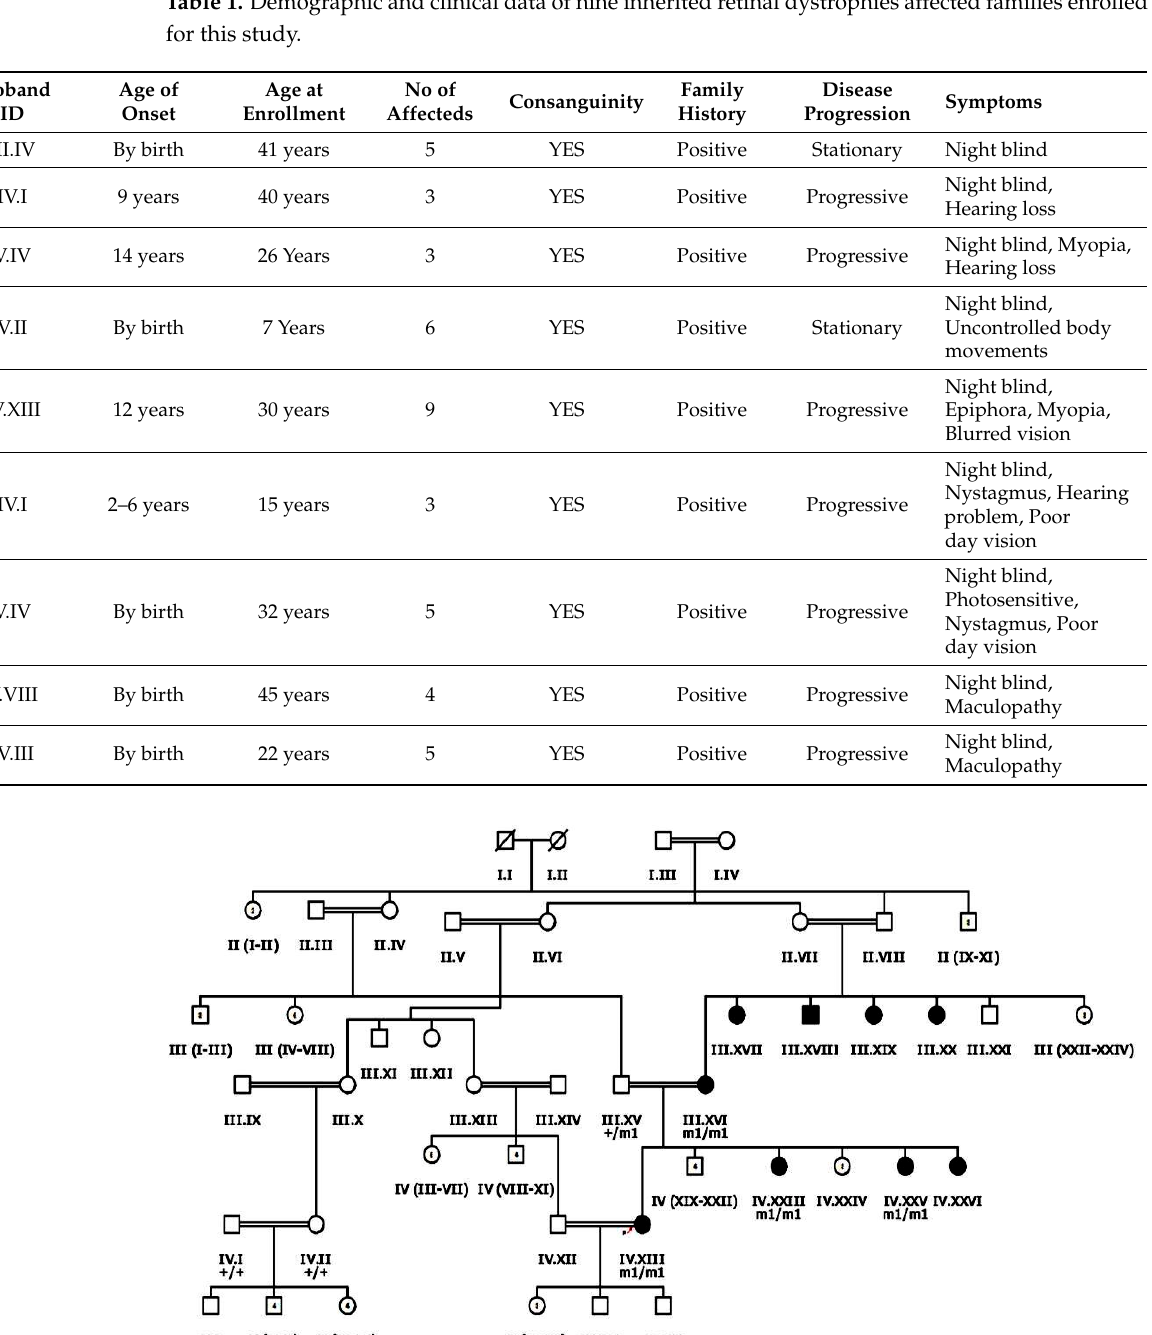
Figure 2. Pedigree drawings of inherited retinal dystrophies families, i.e., ( a ) RP112 and ( b ) RP113 showing autosomal recessive pattern of phenotype in which the novel disease-causing variant in the SPATA7 gene was detected. Squares and circles denote males and females, respectively. Filled symbols show affected, while unfilled symbols show unaffected individuals. Double lines indicate consanguineous union. m1/m1 refers to the homozygous disease-causing variant, whereas m1/+ refers to heterozygous carrier status. In addition to the retinal phenotypes shared by affected individuals of all families, such as night blindness, poor day vision and photosensitivity, three (RP102, RP105 and RP109) out of nine families were suffering from syndromic disease. The affected individ- uals of families RP102, RP105 and RP109 were also suffering from progressive hearing loss. Nystagmus is observed in the affected individuals of family RP109. Fundus examination of probands of all affected families showed typical symptoms, including bone spicule for- mation, waxy pale discs and attenuation of vessels. Fundus photograph and audiometry find- ings of one affected individual (V.II) of family RP105 are shown in Figure 3 (Figure 3a, 3b).